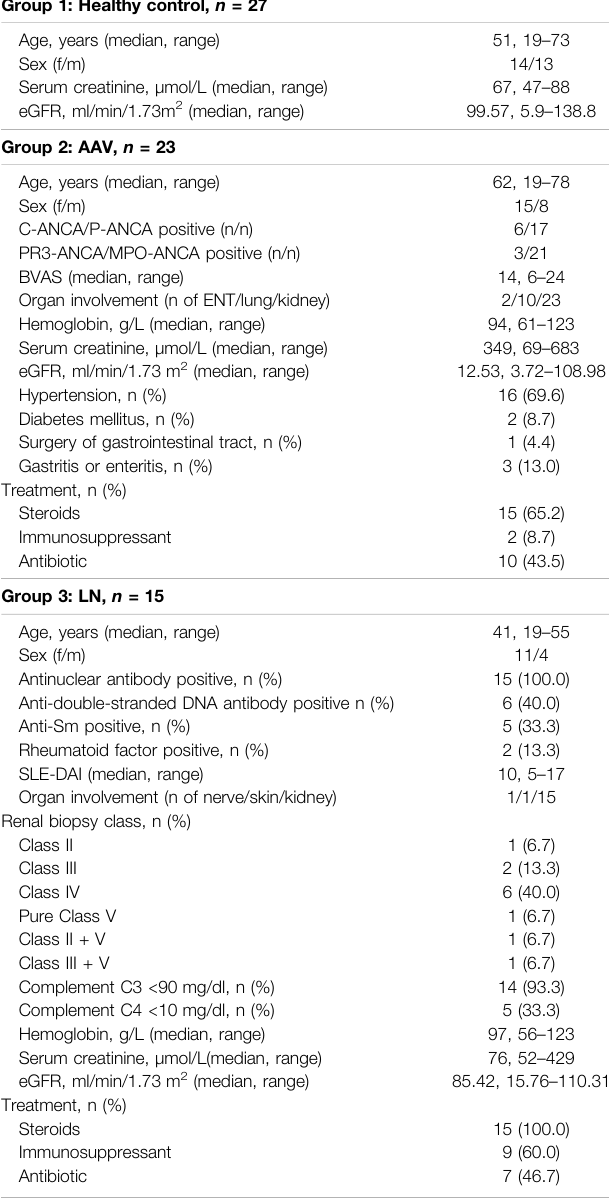
TABLE 1 | Baseline characteristics of subjects included in the study. Group 1: Healthy control, n =